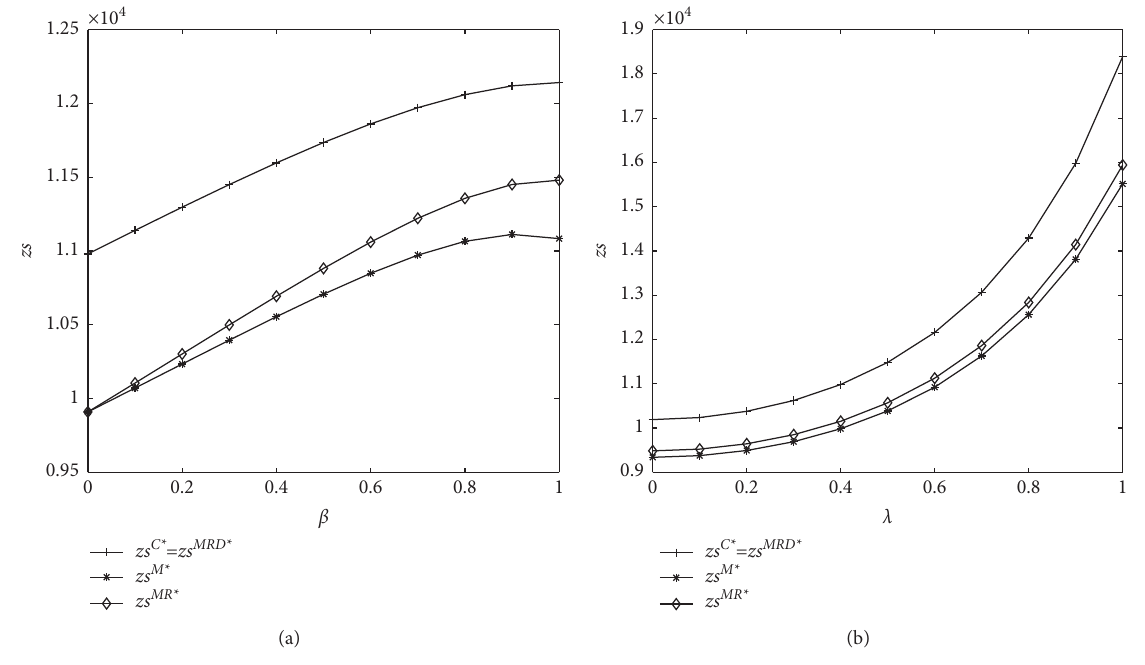
Figure 7: The effect of β and λ on social